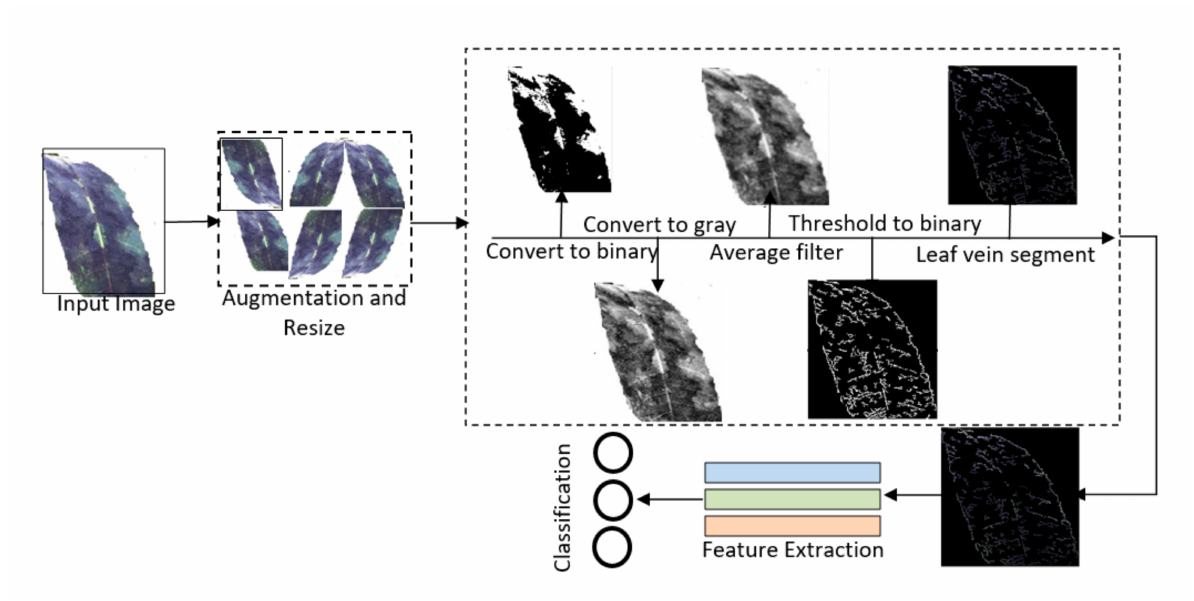
Figure 1. Framework of the proposed computerized system.